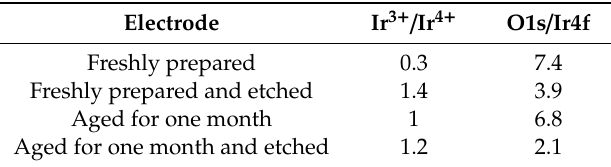
Table 3. Atomic-ratio of Ir 3 + / Ir 4 + and O1s /